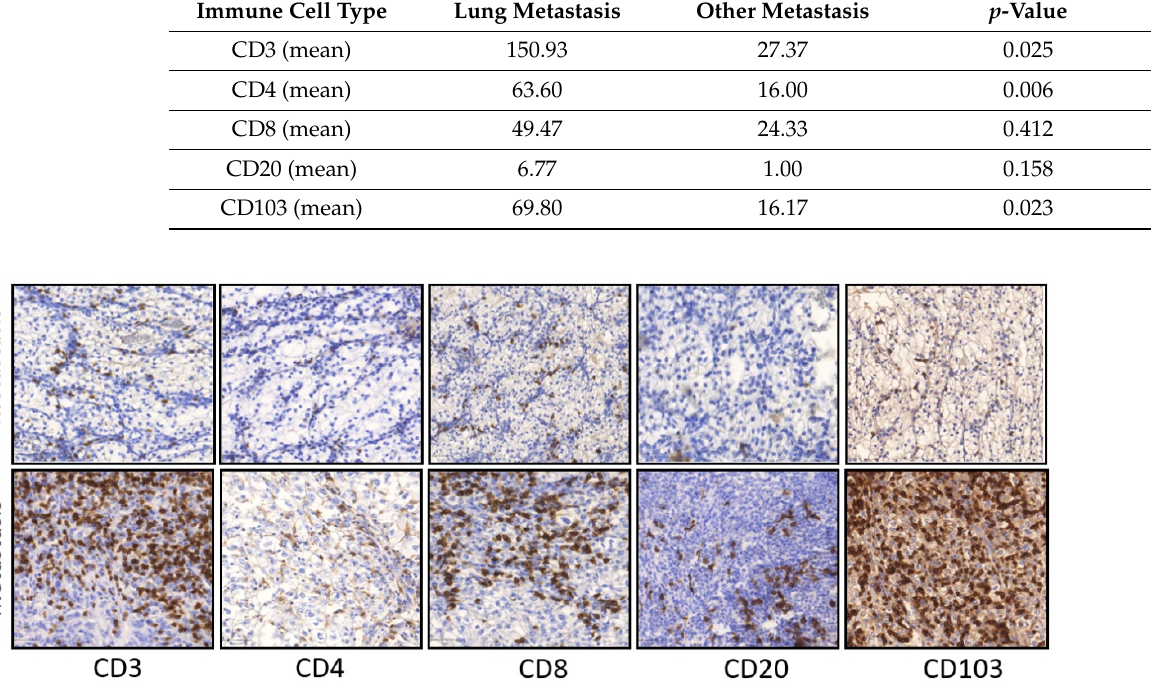
Figure 3. Representative pictures of IHC staining in primary ccRCC in metastatic lesions. Examples CD3, CD4, CD8, CD20 and CD103 infiltration in adrenal gland metastasis and lung metastasis (x 100 magnification). Table 6. Comparison of the immune cell infiltration in distant metastases (Mann–Whitney U test, Bonn cohort, n = 25 patients).